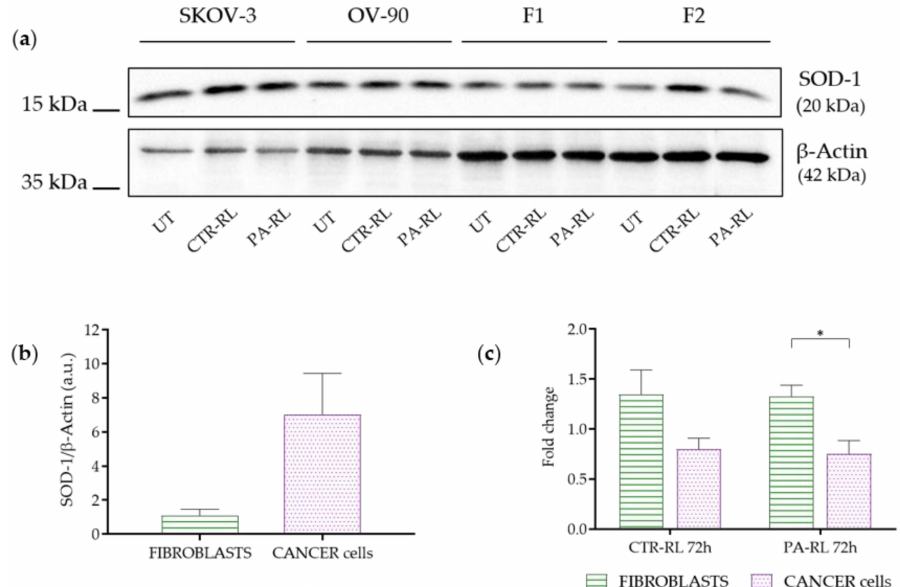
Figure 6. PA-RL solution induces an increase in Superoxide Dismutase-1 (SOD-1) expression in fibroblasts but not in EOC cell lines. ( a ) Western blot analysis of EOC cell lines and fibroblasts (F1 and F2) at 72 h after treatment with PA-RL 1:16 (UT, untreated cells). A representative experiment of three is shown. ( b ) SOD-1 levels in untreated fibroblasts and cancer cell lines. Histograms show densitometric values of the SOD-1 protein normalized to the β -actin used as a loading control. All data are presented as mean ± SEM of three independent experiments. ( c ) Relative densities of SOD-1 and β -actin were measured using densitometric analysis. SOD-1 levels of CTR-RT and PA-RL 1:16 after 72 h of treatment were normalized to β -actin and plotted as fold change relative to the untreated (UT) sample. All data are presented as mean ± SEM of three independent experiments. Statistical significance is specified with asterisks (* p ≤ 0.05 as determined by a paired Student’s t